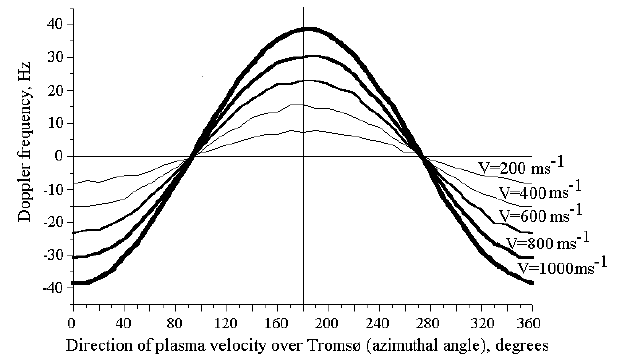
Fig. 5. Three-dimensional view of the simulation of the geometry of diagnostic HF signals scattered from E-region field-aligned irreg- ularities on the London - Tromsø - St.Petersburg path at 9410kHz for the geophysical conditions on 16 February 1996 at 21:20UT. (1) and (2) indicate the different propagation modes from London to Tromsø and from Tromsø to St.Petersburg.